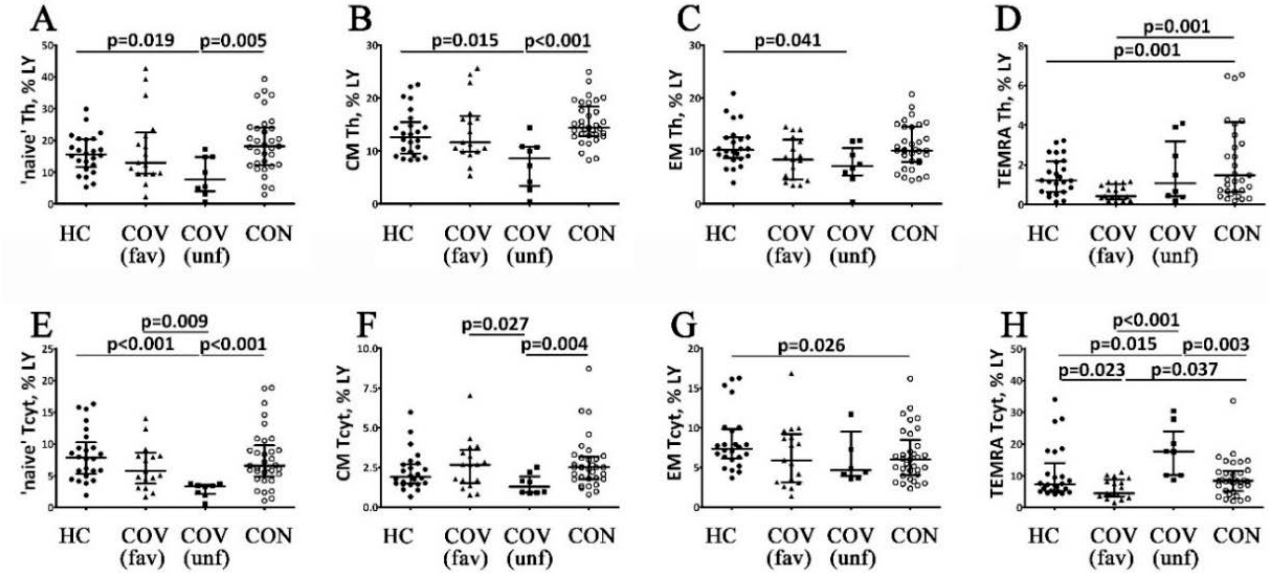
Figure 3. Alterations in relative numbers of T cell subsets with different patterns of CD45RO and CD62L expression in patients with acute COVID-19 and COVID-19 convalescent patients. Scatters plots ( A – D ) and ( E – H ) showing the percentages of ‘naïve’ (CD45RO − CD62L + ), central memory (CM, CD45RO + CD62L + ), effector memory (EM, CD45RO + CD62L − ) and terminally differentiated CD45RA-positive effector memory (TEMRA, CD45RO − CD62L − ) T-helpers and cytotoxic T cells, respectively. The data represents the percentages of T cell subsets within total lymphocyte population. Black circles—healthy control (HC, n = 24); black triangles—patients with acute COVID-19 (COV (fav), favorable outcome, n = 25); black squares—patients with acute COVID-19 (COV (unf), unfavorable outcome, n = 8); and white circles—COVID-19 survivors (CON, convalescent patients with favorable outcome of acute COVID-19, n = 33). Each dot represents individual subjects, and horizontal bars depict the group medians and quartile ranges (Med (Q25; Q75). Statistical analysis was performed with the Mann–Whitney U test.